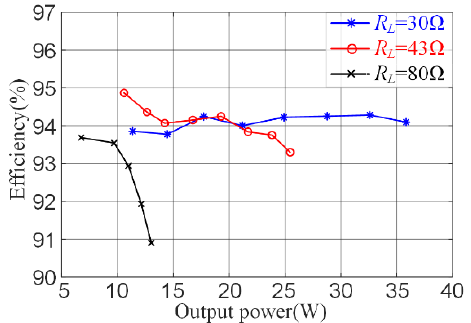
Figure 11. Measured efficiency of the proposed design.